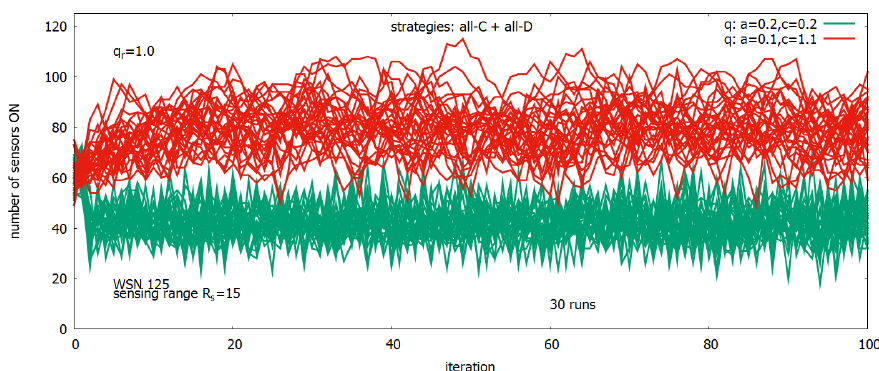
Figure 10. Thirty single runs for a = 0.2, c = 0.2 and (in red) and a = 0.1, c = 1.1 (in